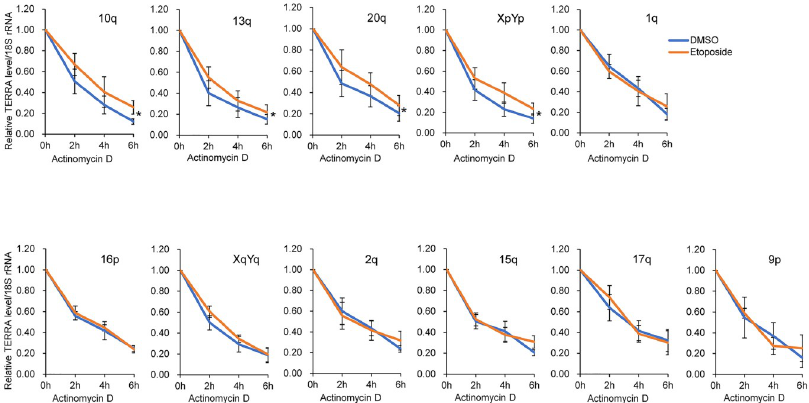
Fig 5. Stability of TERRAs in etoposide-treated cells. HeLa cells incubated with DMSO (vehicle alone) or etoposide at 100 μ M for 24 h were treated with actinomycin D at 5 μ g/mL for the indicated times. TERRAs were measured using RT–qPCR with primers as indicated, normalized against 18S rRNA, and compared with 0 h. Error bars are SDs derived from at least five independent experiments. Student’s t -tests were used to compare differences in TERRA levels between etoposide- and DMSO-treated cells; � P <